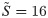
Comparison of approximate solution (for S˜=16, t = 1, Δt = 0.01 and j˜=0.17) and exact solution for Test Problem 1.